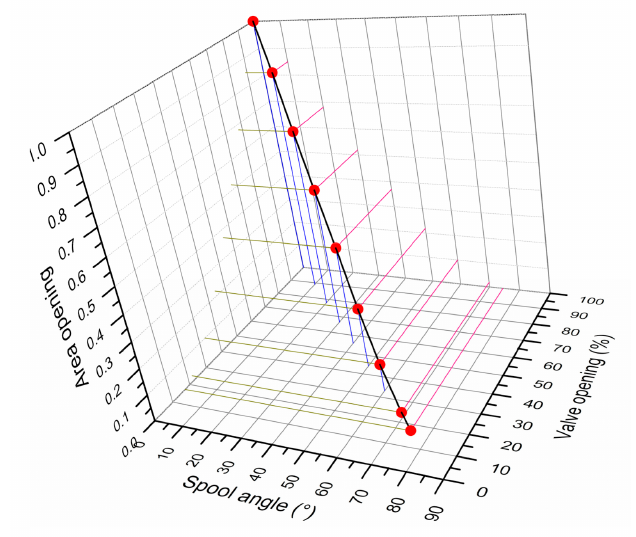
Figure 3. Relationship between ball valve opening, area opening and spool